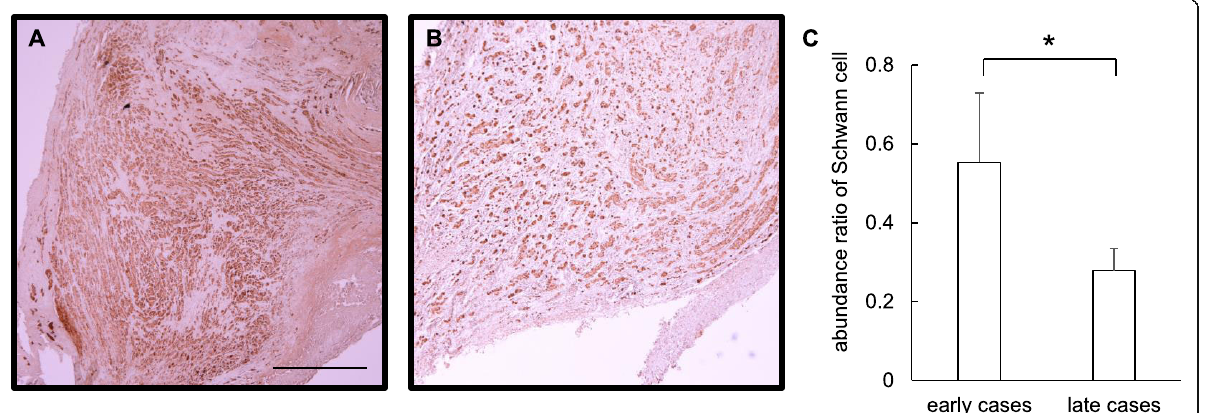
Fig. 2 Effect of duration from lingual nerve injury to the microneurosurgery on Schwann cells in traumatic neuroma. Immunohistochemistry using anti-S100 β antibody was performed on traumatic neuroma samples from early cases ( a ) and later cases ( b ). The abundance ratio of Schwann cells was significantly lower in the traumatic neuroma samples from later cases ( c ). Scale bar indicates 500 μ m. Asterisk indicates significant difference between early and later cases ( P <